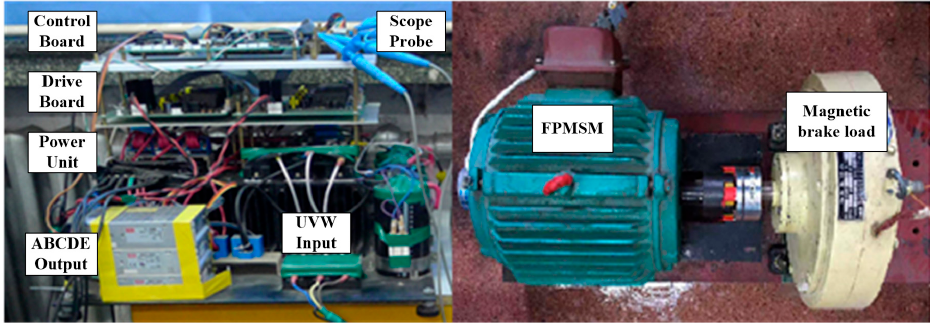
Figure A1. The experimental platform of five-phase PMSM drive system.